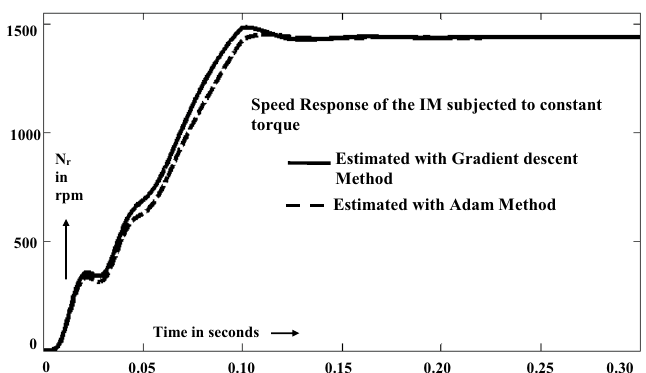
Fig. 8 Speed Response of IFOC VSI-IM drive with constant load